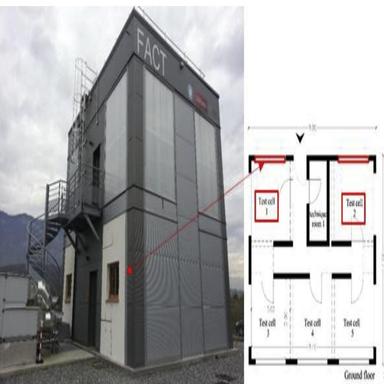
Test cells 1 and 2 used to characterize the hygrothermal performance of the aerogel based ETICS and the ITI systems.